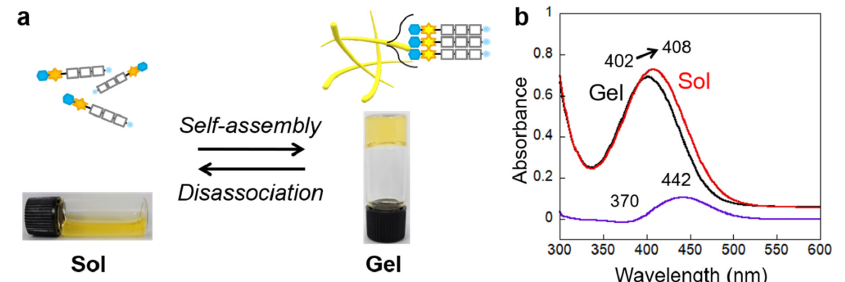
Figure 4. ( a ) Photographs and schematics of a supramolecular hydrogel of β Gal–AAC–C6–F3 ex- hibiting reversible thermal gel–sol transition and thermochromism and ( b ) UV–Vis absorption spectral changes of the supramolecular hydrogel of β Gal–AAC–C6–F3 upon heating (black line: 25 °C (gel state), red line: 85 °C (solution state), purple line: differential spectrum). Conditions: [ β Gal– AAC–C6–F3] = 0.19 wt%, 200 mM HEPES–NaOH buffer (pH 8.0).